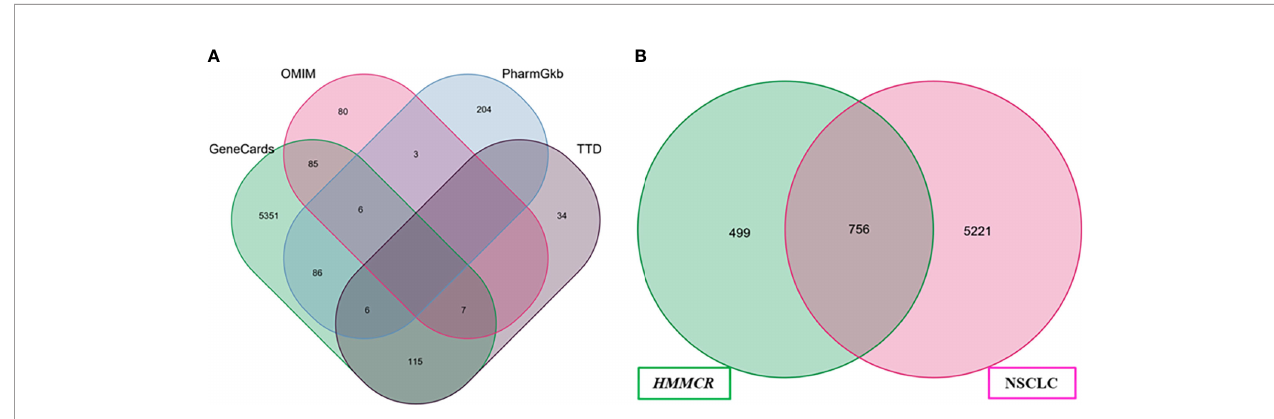
FIGURE 2 | (A) The Venn diagram of NSCLC-related targets obtained from four public database. (B) Venn diagram of compounds and NSCLC